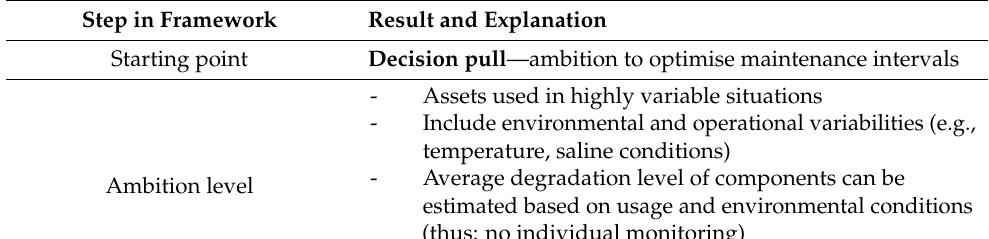
Table 3. Application of the decision framework to case